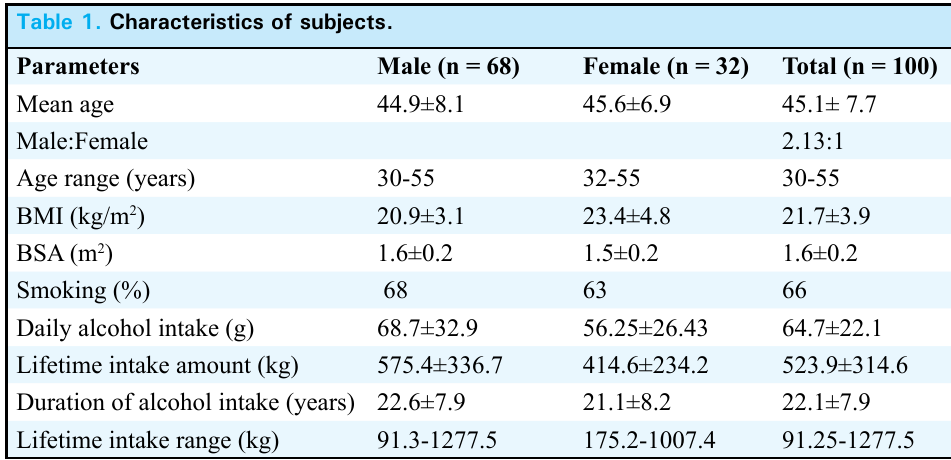
Table 1. Characteristics of subjects.